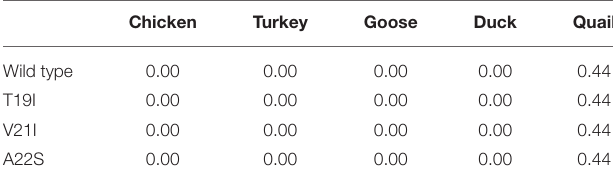
TABLE 7 | AMYCO analysis according to alleles of avian PrPs.